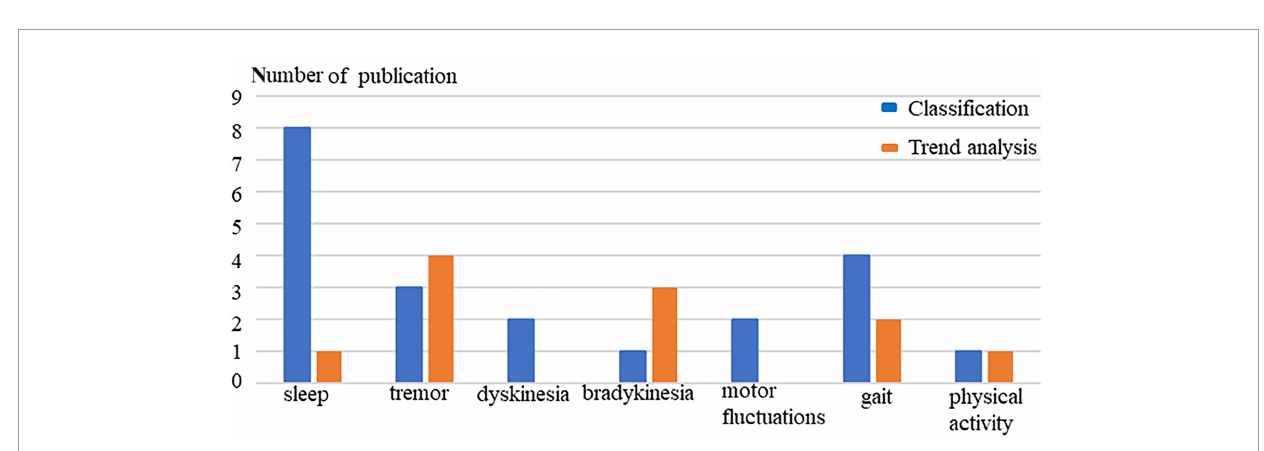
FIGURE4 The technological application of wrist-worn sensors in monitoring PD symptoms. Classification (blue): Prediction and detection of symptoms; Trend analysis (orange): Progression or change of